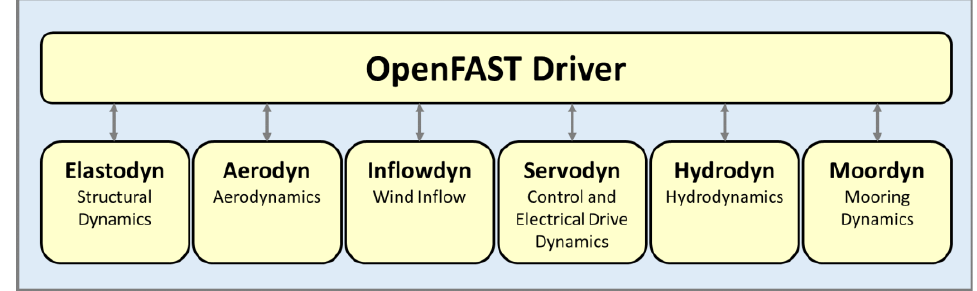
Figure 2. Various modules connected by OpenFAST (Figure adapted from [16]).